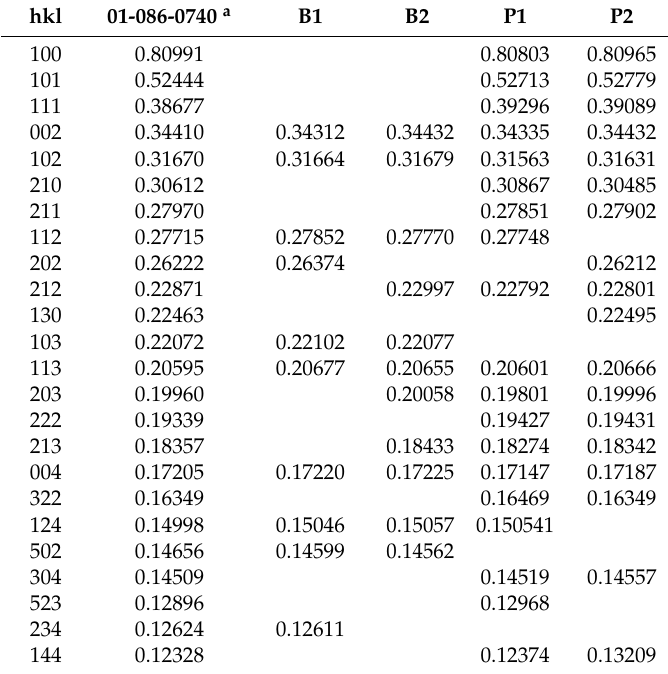
Table 1. XRD data of HAP in bones of Cololabis saira